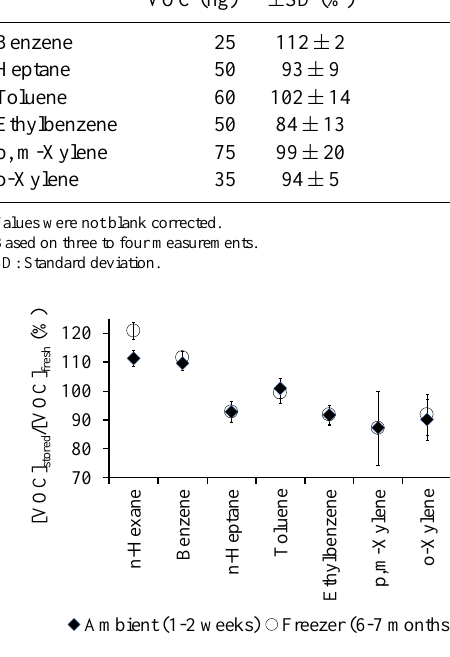
Figure 4. Impact of storage on sample recovery for storage of 1 to 2 weeks at ambient temperatures (diamonds) and 6 to 7 months in a freezer (circles). The recovered masses are given relative to samples analyzed immediately after sampling. Both storage tests used the same reference values. Values used are the average of three to four measurements and the error bars show the variability of results for analysis after storage. Masses loaded range from 25 to 75ng. Values were not corrected for blanks.